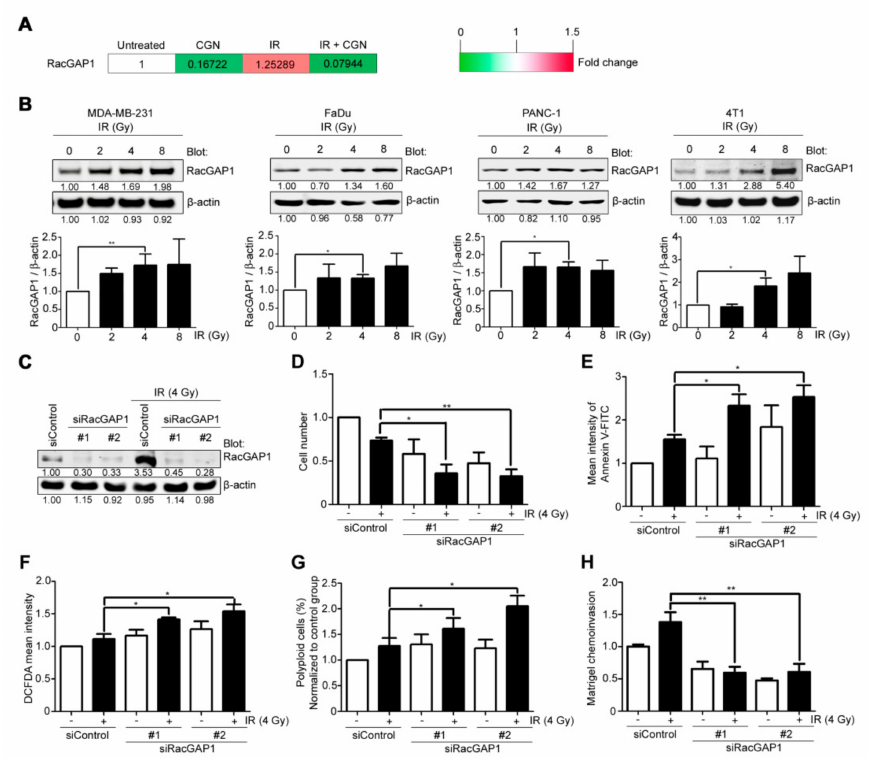
Figure 4. Upregulation of RacGAP1 is involved in cancer cell survival and invasion after IR. ( A ) Gene expression was analyzed by cDNA microarray. RacGAP1 expression level is shown by the heat map. The values were normalized to the untreated group. ( B ) RacGAP1 protein expressions with di ff erent doses of IR were analyzed in MDA-MB-231, FaDu, PANC-1, and 4T1 cell lines. ( C ) MDA-MB-231 cells were transfected with siRNA duplexes targeting RacGAP1 (# 1 or # 2) or the control sequence, as indicated. Cell lysates were subjected to western blot two days after transfection. ( D – H ) MDA-MB-231 cells were transfected with siRNAs and incubated for two days, and then treated with 4 Gy IR. Each experiment was performed 24 h after IR treatment. Cell viability was quantified by cell counting ( D ). Apoptotic cells were measured by Annexin V-FITC staining and flow cytometry ( E ). ROS was measured by DCFDA ( F ). Cells were treated with staining solution and PI, and then the cell cycle was analyzed by flow cytometry. The percentage of polyploid cells in each group was normalized with control group ( G ). The invasive activity was measured by Matrigel chemoinvasion assay ( H ). Columns, mean ( n ≥ 3); bars, SE. *, p < 0.05; **, p < 0.01. Data shown in ( D – H ) were normalized to that of MDA-MB-231 cells transfected with siRNA control. For the continuous full length-image of Western blot signals, please refer to Supplementary Materials Figure